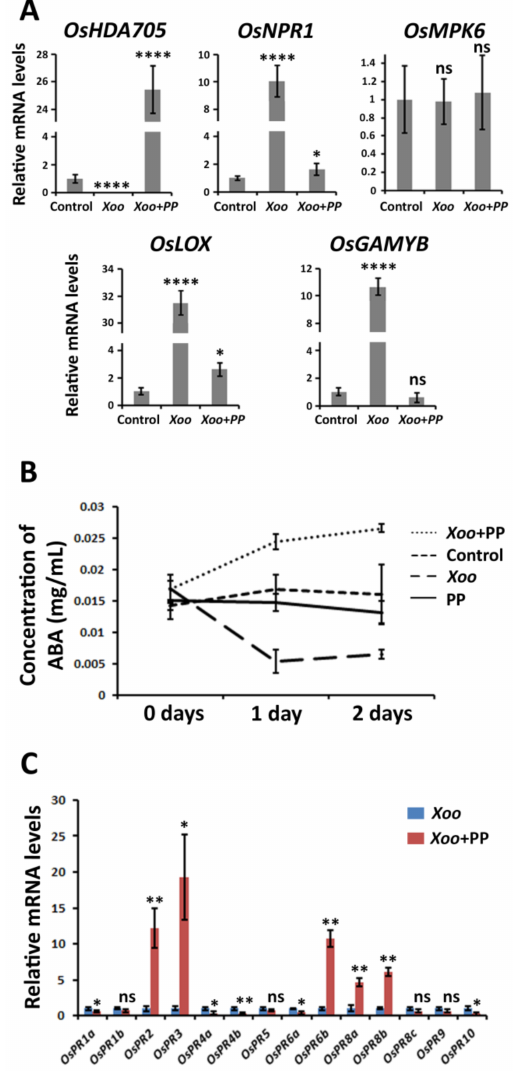
Figure 4. P. putida induces an alternative defense mechanism in X. oryzae pv. oryzae -infected rice plants. ( A ) mRNA levels of relevant signaling genes related to rice defense. RNA extraction from rice leaves was carried out 2 days after pathogen inoculation. ( B ) Concentration of ABA in X. oryzae pv. oryzae -infected rice plants in the presence and absence of P. putida . The control experiment was performed in the absence of pathogen and rhizobacteria. ( C ) mRNA levels of pathogenesis-related proteins (PRs) in X. oryzae pv. oryzae -infected rice plants in the presence and absence of P. putida . Significance levels at p < 0.05 (*), p < 0.01 (**), p < 0.0001 (****) and no significance